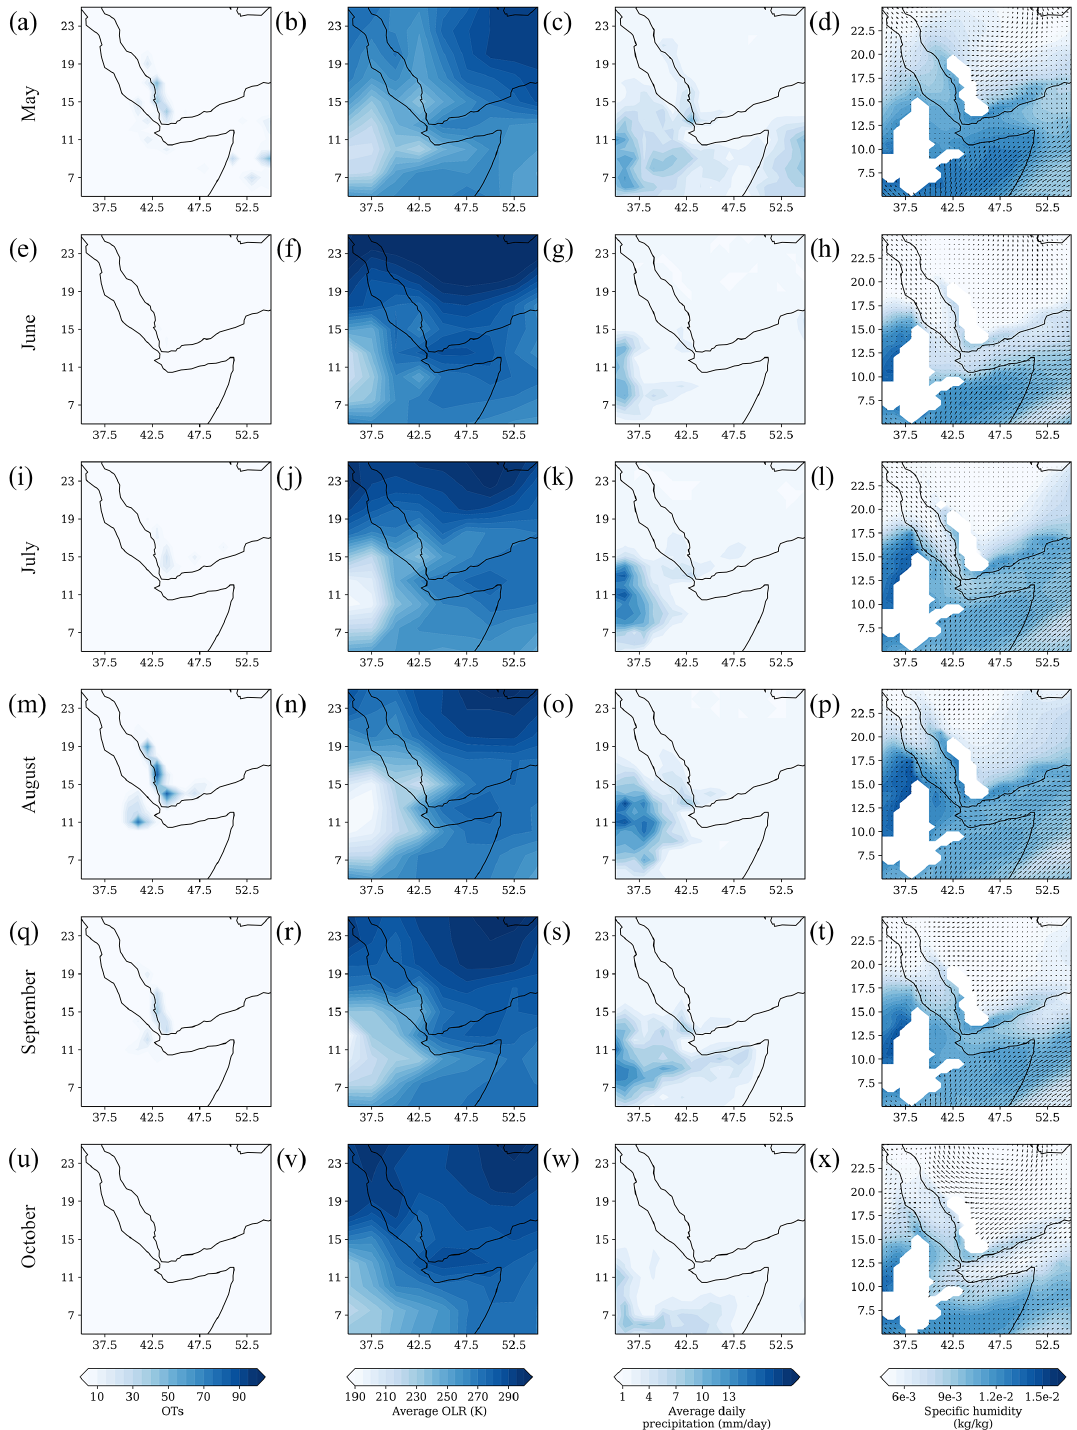
Figure 9. The geographic distribution of monthly convection over eastern Africa and the southwestern Arabian Peninsula as shown by OTs (first column), daily average OLR (second column), and daily average precipitation (third column). Additionally, the specific humidity and wind vectors at 850hPa from MERRA-2 are shown (fourth